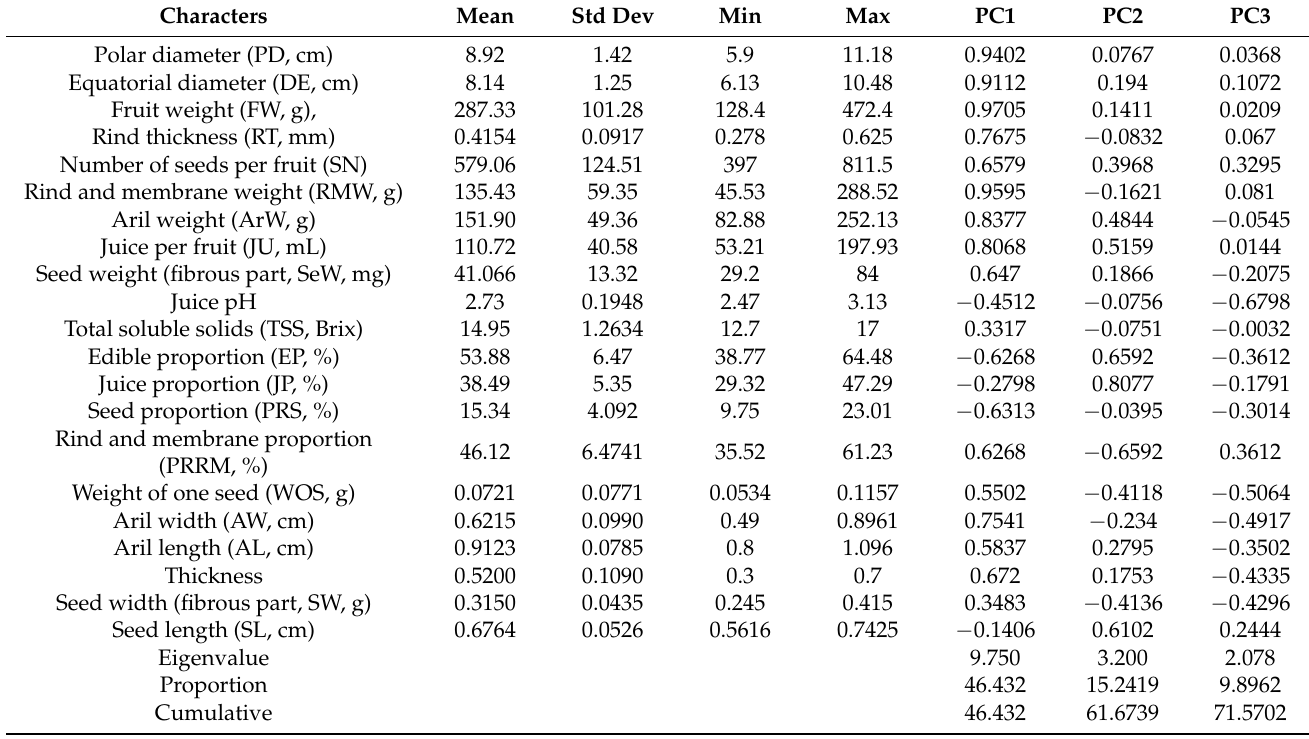
Table 2. Descriptive statistics and eigenvector coefficients of quantitative fruit characters evaluated in Punica granatum genotypes from south